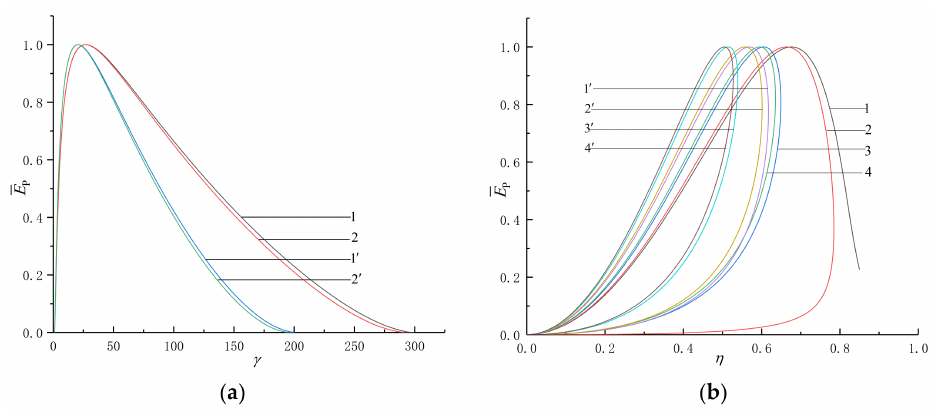
Figure 4. Effects of η c η e B and µ on E P − γ and E P − η . ( a ) E P − γ . ( b ) E P − η